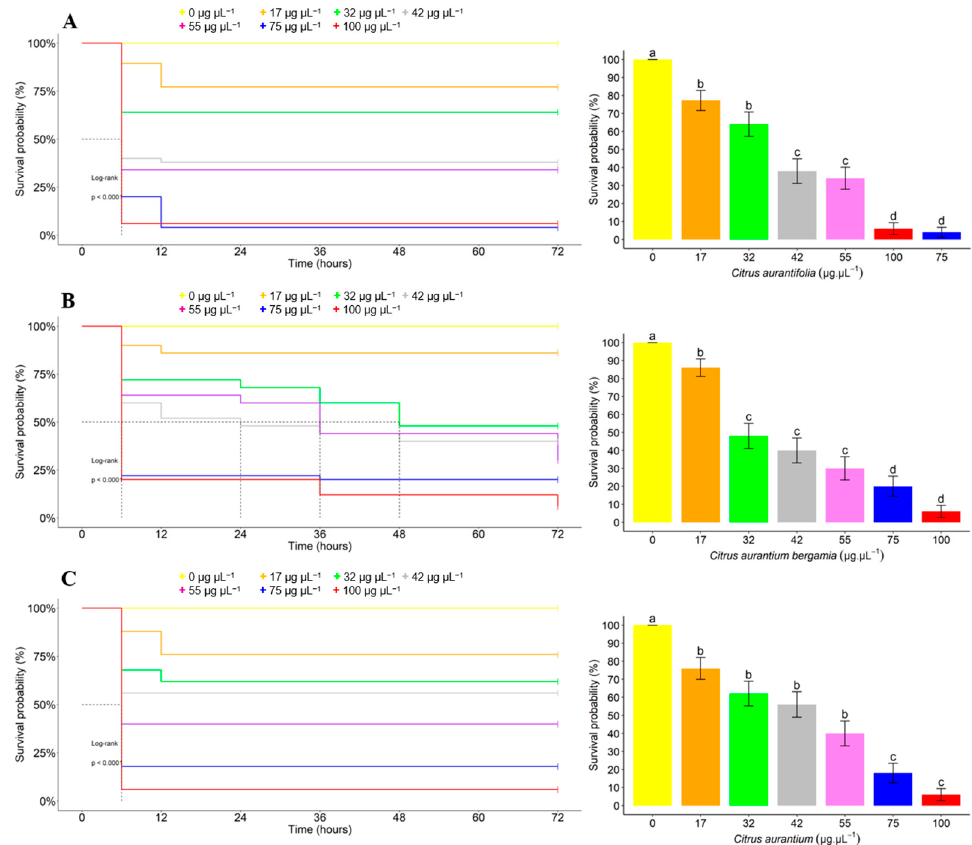
Figure 2. Survival curves, estimated by the Kaplan–Meier method, of Tuta absoluta larvae over time submitted to topical application with different concentrations of Citrus aurantifolia ( A ), Citrus aurantium ( B ) and Citrus aurantium bergamia ( C ). Similar lowercase letters indicate no significant differences between treatments ( p < 0.01).